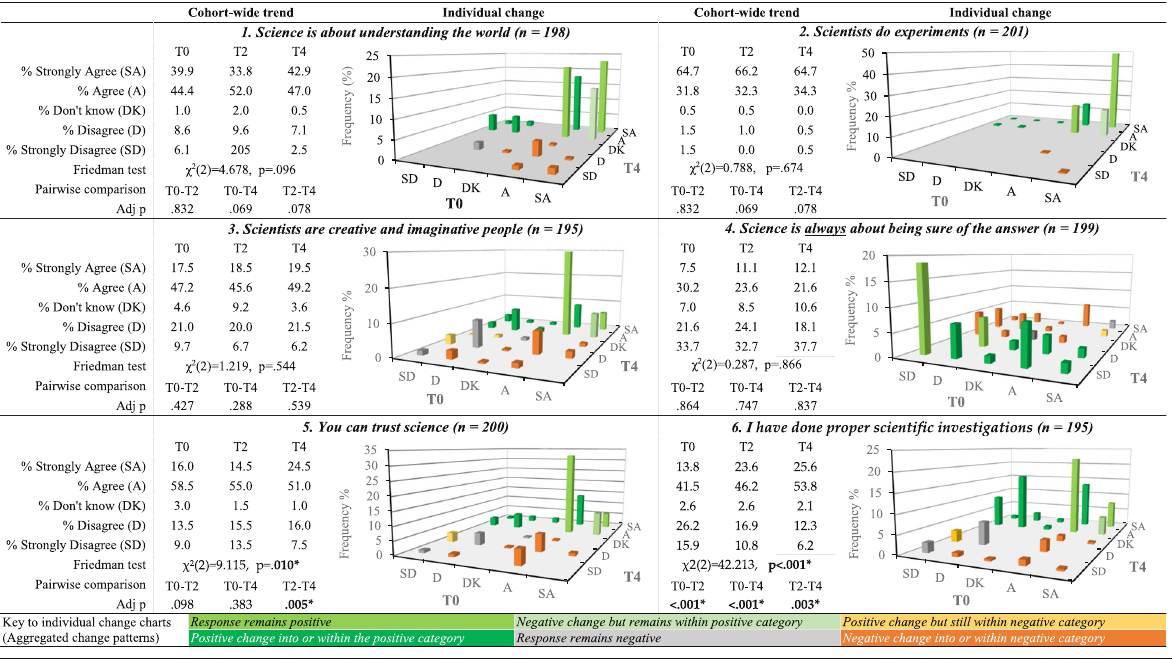
Variance in distribution of matched responses at T0, T2, and T4 was measured using the Friedman test. Post hoc pairwise comparisons were conducted using Wilcoxon Signed-Rank